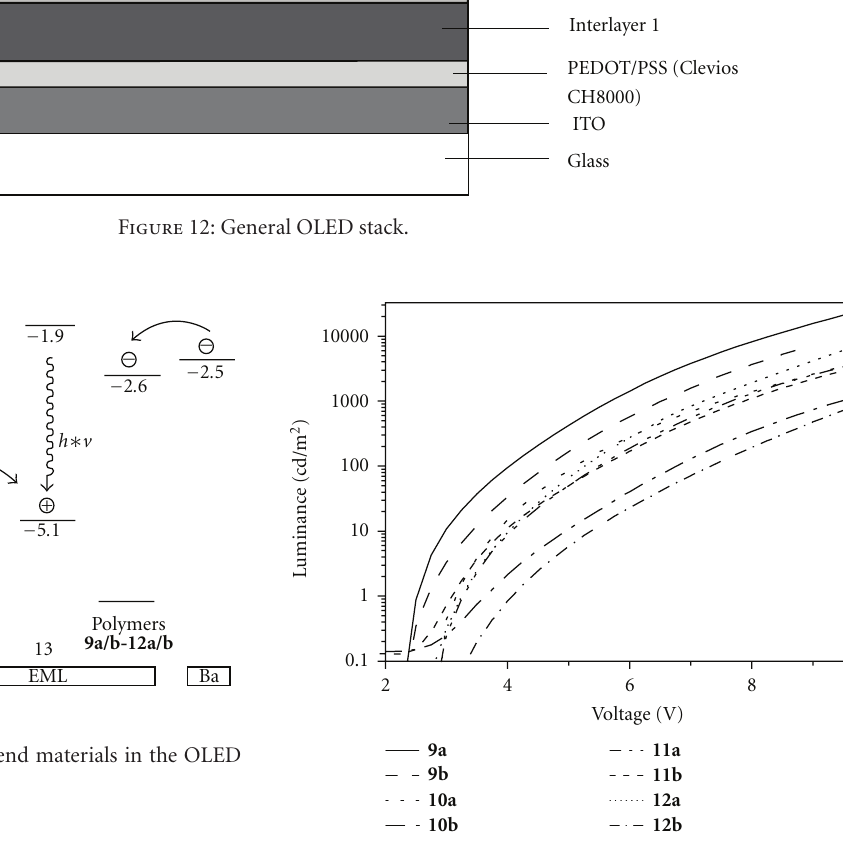
Figure 14: Luminance-voltage plot of OLEDs depending on the used electron-transporting polymers 9a/b – 12a/b